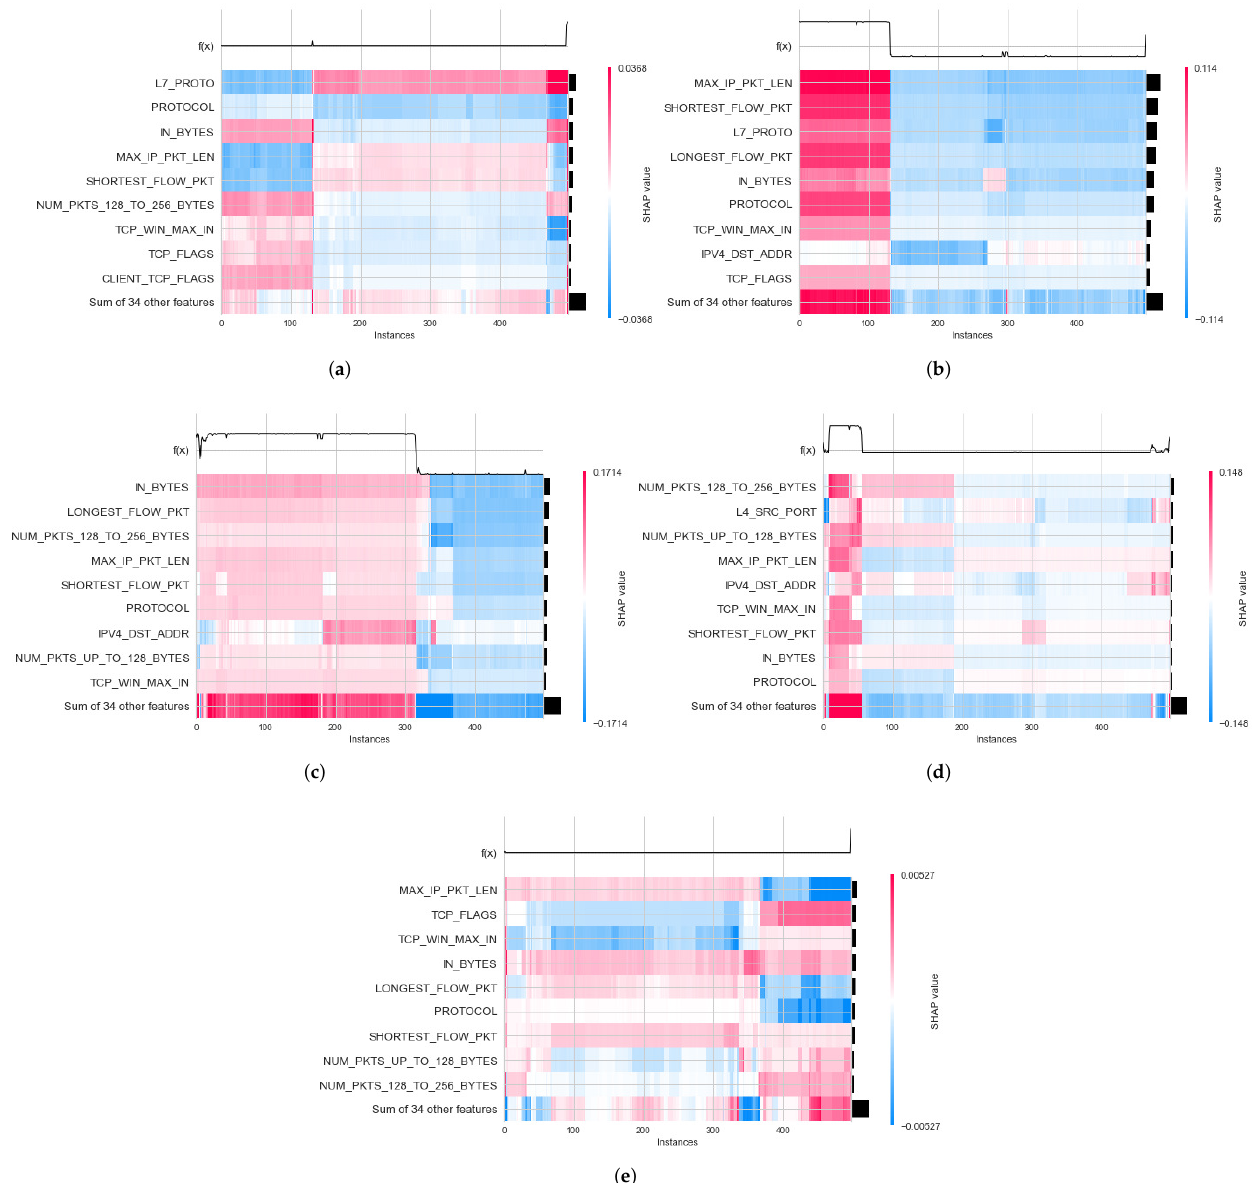
Figure 12. Heatmap results of global explanation for NF-BoT-IoT-v2 of NetFlow V2 dataset in five Cat output values: ( a ) 0—DoS; ( b ) 1—DDoS; ( c ) 2—Reconnaissance; ( d ) 3—Benign; ( e )